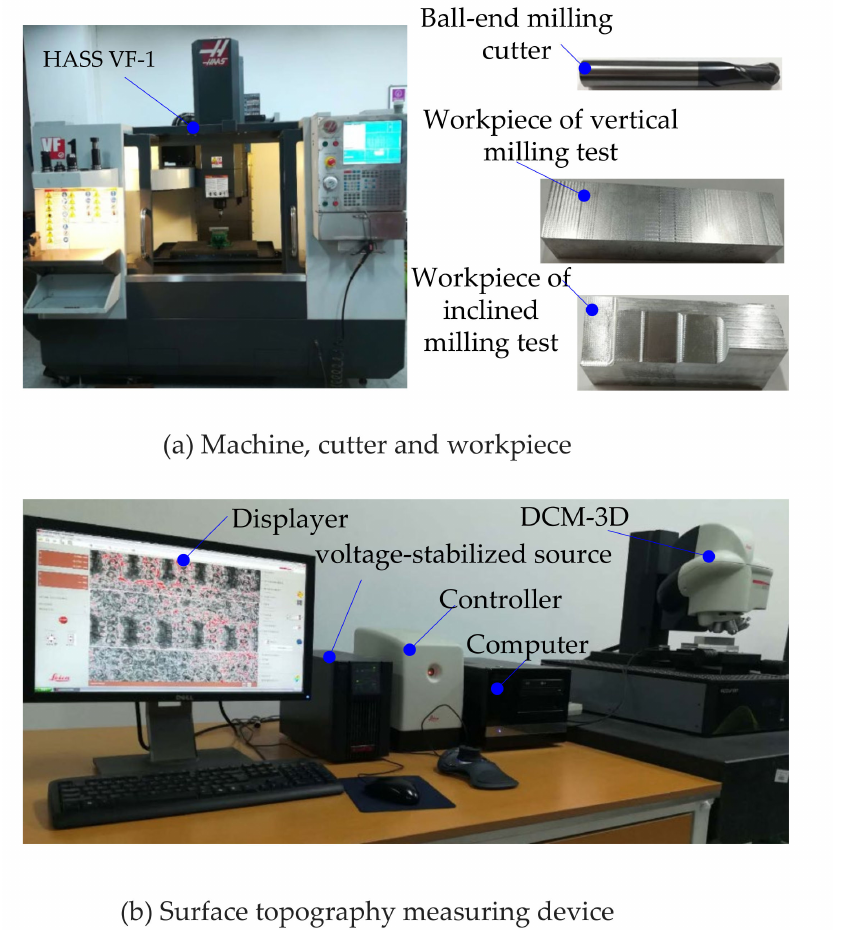
Figure 9. Milling and measuring